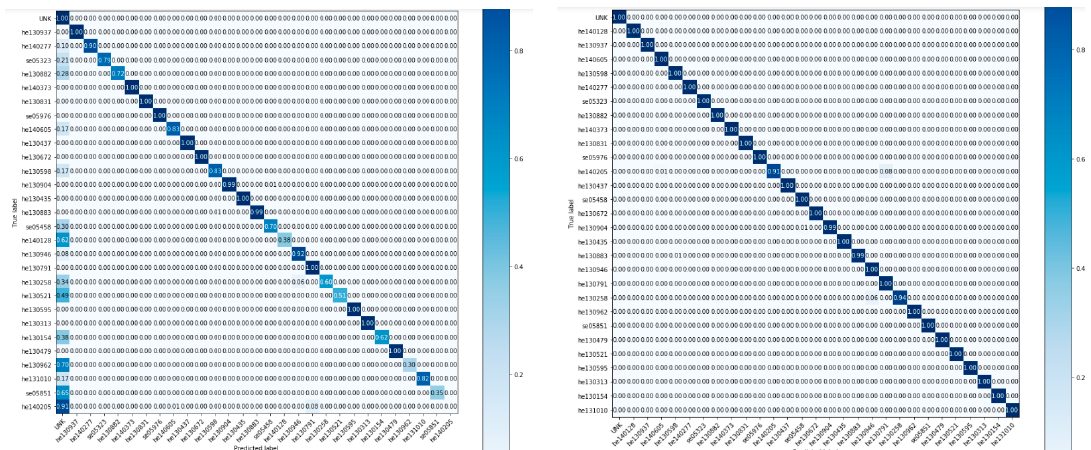
Figure 6. Confusion matrix of ID identification task: no assist (left) and semi-assist (right).